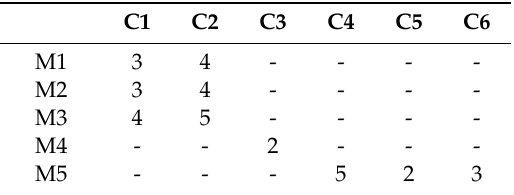
Table 8. Processing time with priority relation (PR) in DAG